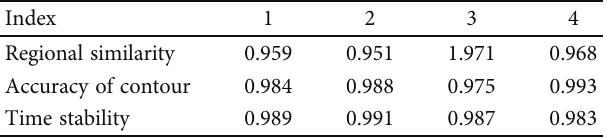
Table 2: Experimental results of indicators.